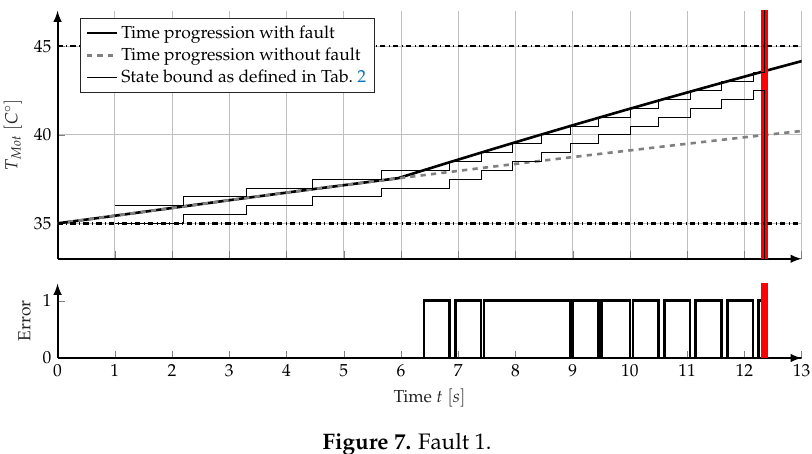
Figure 7. Fault 1.